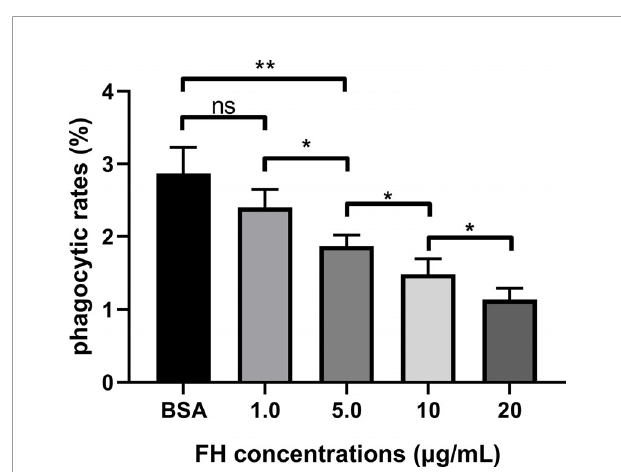
FIGURE 6 | FH recruitment contributed to the anti-opsonophagocytic ability of ExPEC. ExPEC strain RS218 pre-incubated with puri fi ed human FH and incubated with 10% FH-depleted human serum. Then the opsonized bacteria were infected to THP-1 cells or performed plate counting. The phagocytic rates were determined as ratios of the number of bacteria recovered from THP-1 to those recovered from human serum. The data are expressed as the mean ± SEM of three independent experiments. The statistical signi fi cance of differences between each pair was determined using the unpaired t -test (*p < 0.05; **p < 0.01; ns, no signi fi